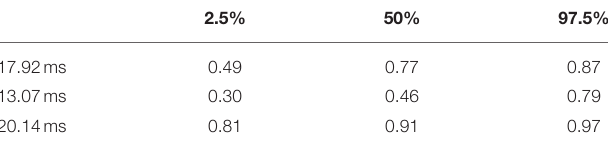
TABLE 4 | 95% confidence intervals for PTT respiratory swing specificity at three thresholds (training data).